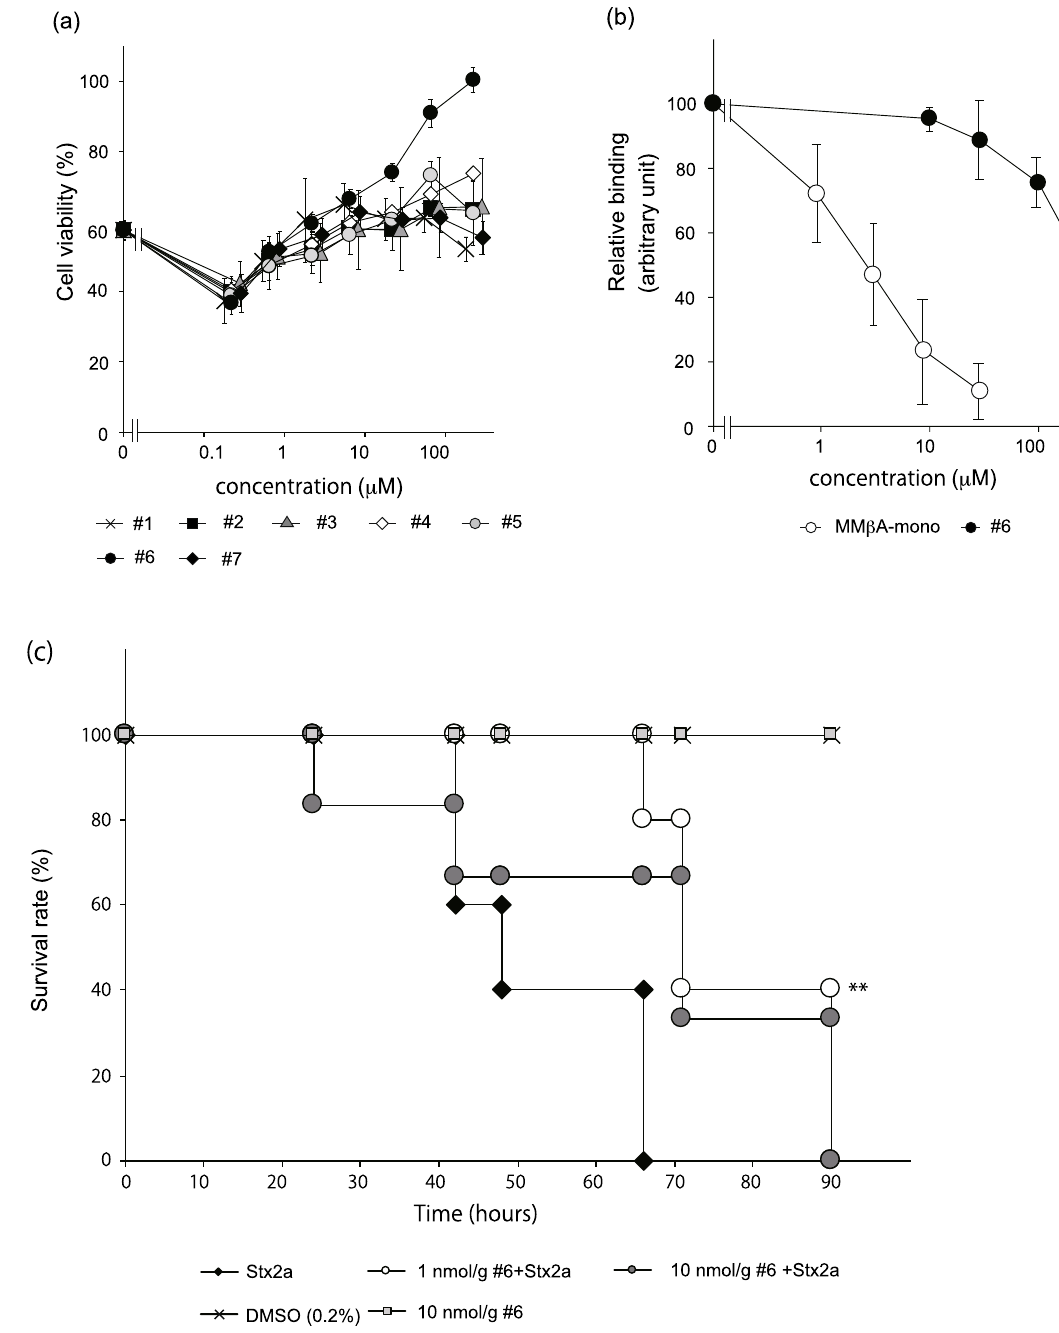
Figure 6. Compound #6 inhibits toxicity of Stx2a. ( a ) Vero cells were treated with Stx2a for 72 h in the presence of each compound. Data are presented as a percentage of the control value (mean ± SE, n = 3). ( b ) The AlphaScreen assay was used to measure the inhibitory effects of non-tagged MMβA-mono or compound #6 (dissolved in final 0.4% DMSO) on binding between the Stx2a A-subunit and MMβA-mono. Data are presented as a percentage of the control value without peptides (mean ± SE, n = 3). ( c ) Mice were intravenously administered a lethal dose of Stx2a (0.5 ng/g of body weight; n = 5) alone or with compound #6 (1 or 10 nmol/g of body weight; n = 5 and 6, respectively). Control mice were treated with 0.2% dimethyl sulfoxide (DMSO)– phosphate-buffered saline (PBS) ( n = 5) or compound #6 (10 nmol /g of body weight; n = 5) alone. Data indicate the survival rate of each group during the first 4 days after exposure. * P < 0.05 compared with Stx2a, as determined by Log-rank